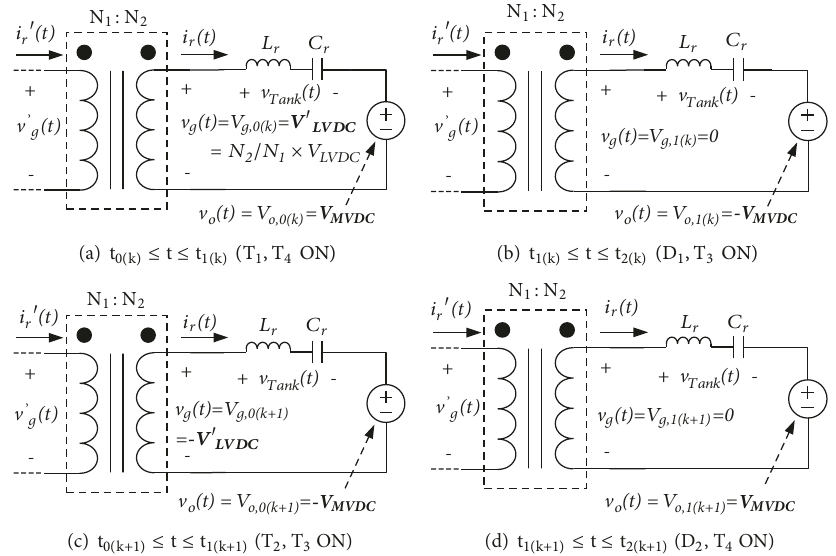
Figure 6: Equivalent circuit of SRC for large-signal analysis of conduction intervals in subresonant